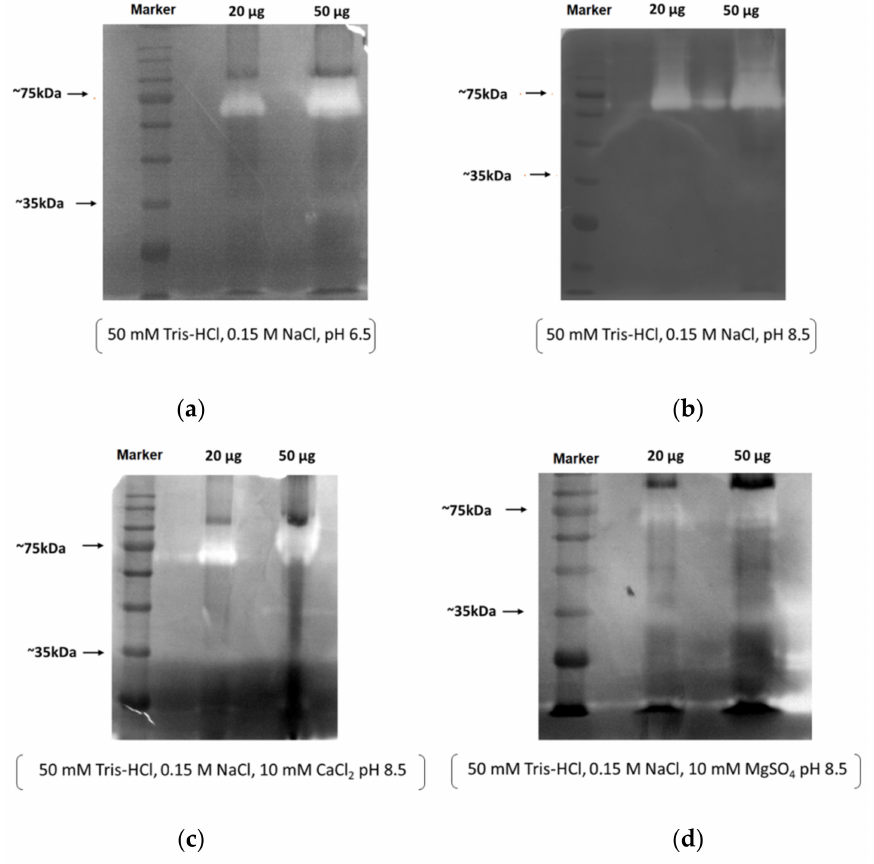
Figure 4. Zymographs of the A. platensis lysate with casein as a substrate and different buffers: ( a ) 50 mM Tris-HCl, 0.15 M NaCl, pH 6.5, ( b ) 50 mM Tris-HCl, 0.15 M NaCl, pH 8.5, ( c ) 50 mM Tris-HCl, 0.15 M NaCl, 10 mM CaCl 2 , pH 8.5, ( d ) 50 mM Tris-HCl, 0.15 M NaCl, 10 mM MgSO 4 , pH